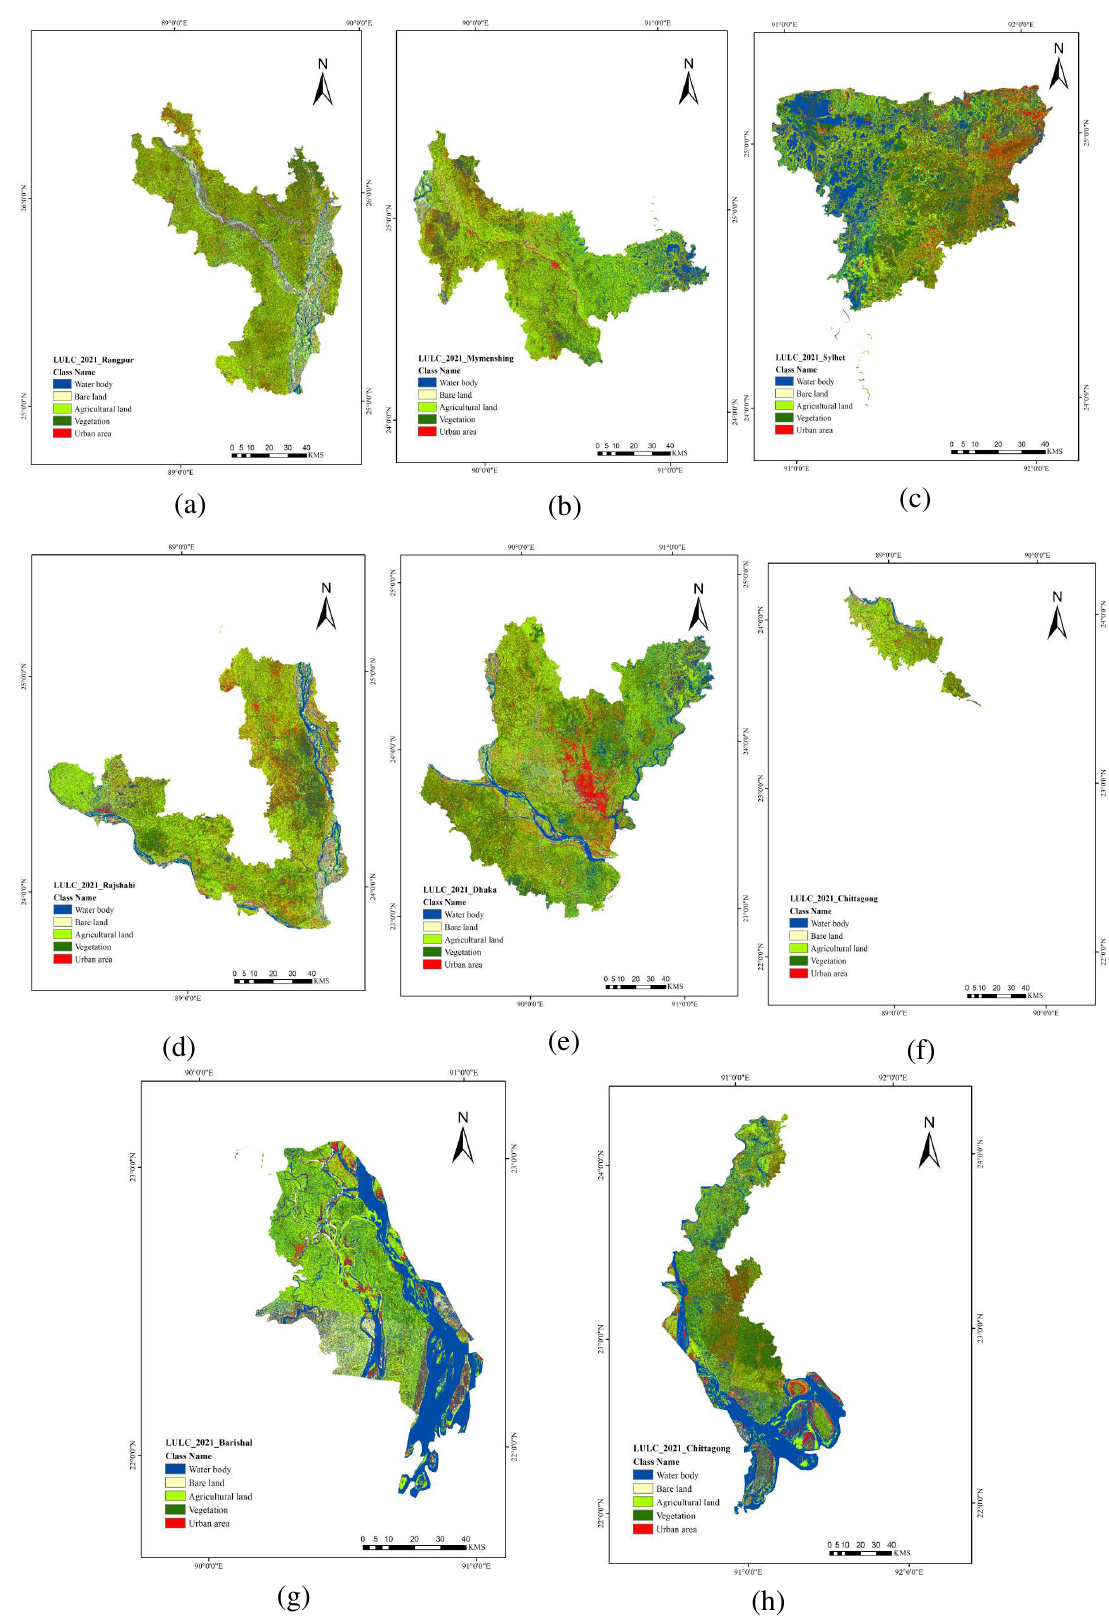
Figure 7. LULC map for all administrative divisions of Bangladesh for 2021; ( a ) Rangpur; ( b ) My- mensingh; ( c ) Sylhet; ( d ) Rajshahi; ( e ) Dhaka; ( f ) Khulna; ( g ) Barishal and ( h ) Chittagong.